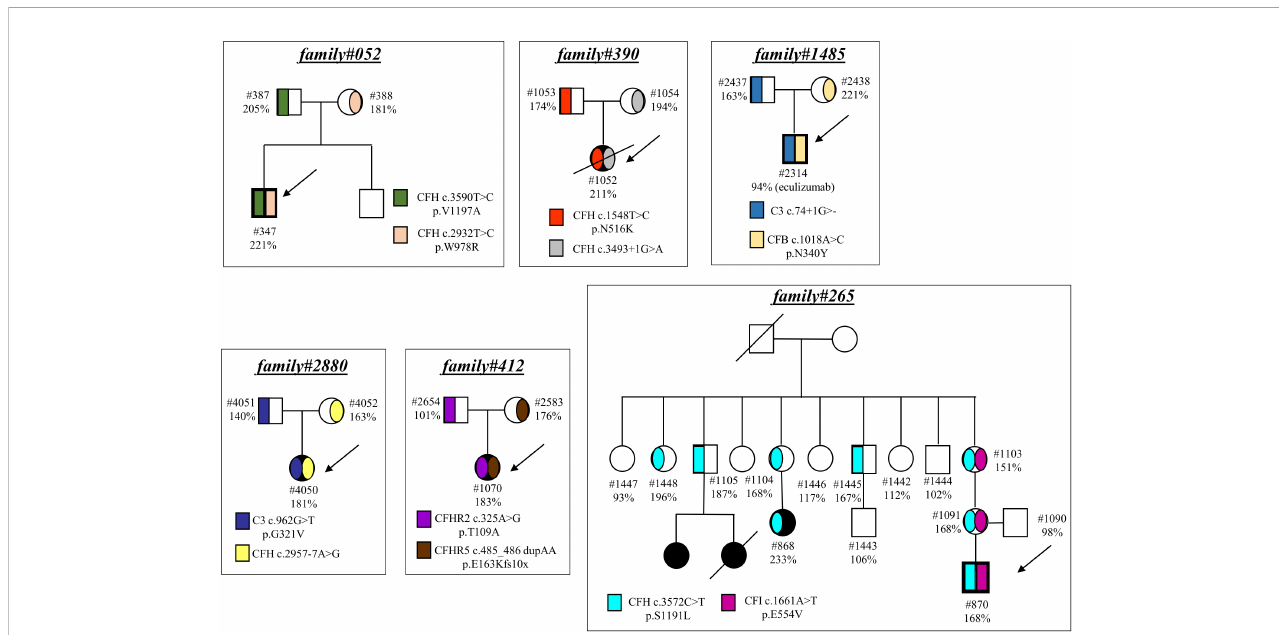
FIGURE 4 Pedigrees with combined variants. Pedigree #052 of the proband #347. Genetic analysis revealed a pathogenic variant in CFH (p.V1197A) inherited from the father (#387, green) and also a LPV in CFH (p.W978R) inherited from the mother (#388, pink). Pedigree #390 of the aHUS proband #1052. Genetic analysis revealed a pathogenic variant in CFH (c.3493+1G>A) inherited from the mother (#1054, grey) and a rare VUS in CFH (p.N516K) inherited from the father (#1053, red). Pedigree #265 of proband #870 carrying a pathogenic variant in CFH (p.S1191L, light blue) inherited from the mother and also present in the maternal affected relative (#868). Genetic analysis in the proband also found a VUS in CFI (p.E554V, purple) inherited from the mother but absent in the maternal affected relative. Pedigree #1485 of proband #2314. Genetic analysis revealed a VUS in C3 (c.74+1delG) inherited from the father (#2437, blue) and a VUS in CFB (p.N340Y) inherited from the mother (#2438, orange). Arrows indicate probands, affected subjects are in black. Pedigree #2880 of the proband #4050. Genetic analysis revealed a LPV in C3 (p.G321V) inherited from the father (#4051, deep blue) and a likely benign variant in CFH (c.2957-7A>G) inherited from the mother (#4052, yellow). Pedigree #412 of the proband #1070. Genetic analysis revealed a benign variant in CFHR2 (p.T109A) inherited from the father (#2654, purple) and a LPV in CFHR5 (p.E163Kfs10x) inherited from the mother (#2583, brown). Arrows indicate probands, affected subjects are in black. The circles are used for female subjects and squares for male